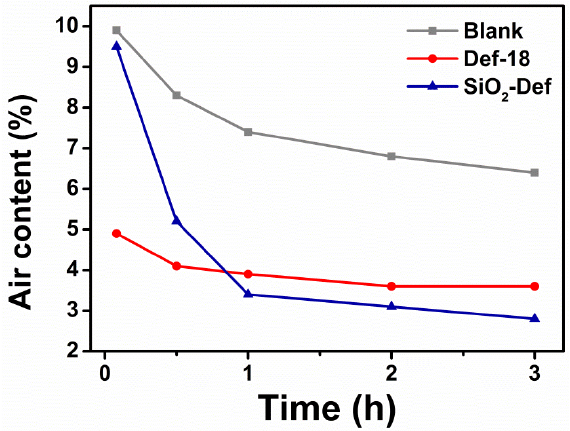
Figure 9. Air content (%) of blank, Def-18 and SiO 2 -Def in fresh cement mortars.